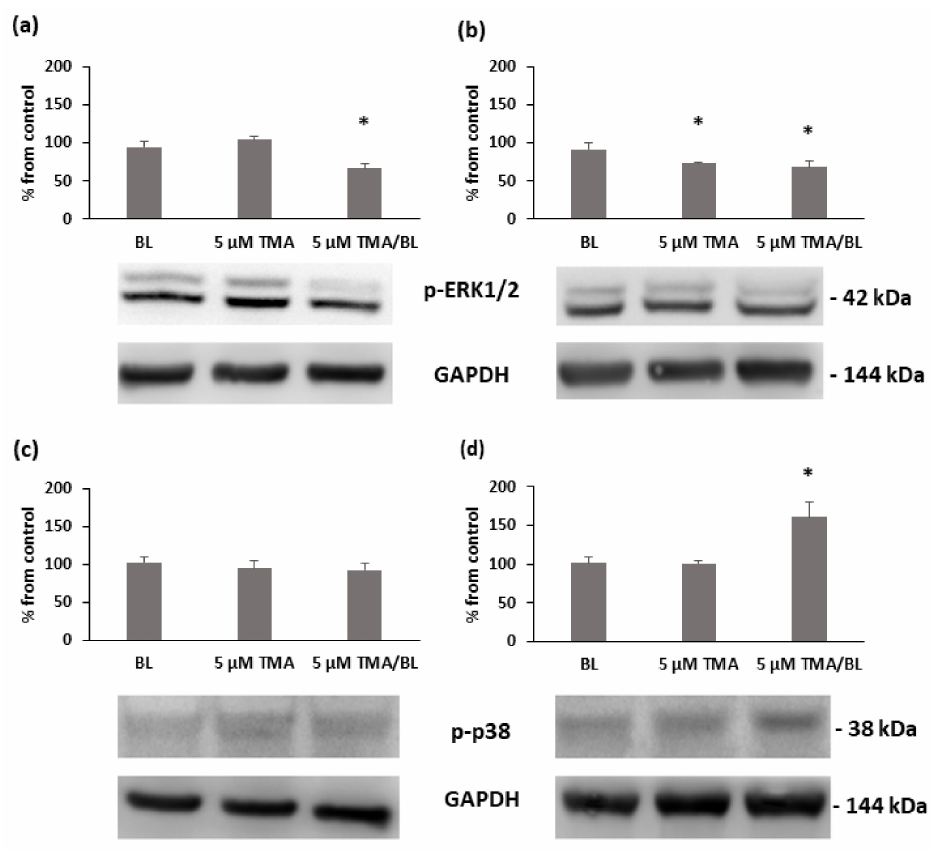
Figure 8. Expression of the phosphorylated forms of ERK 1/2 ( a , b ) and p38 ( c , d ) at 24 ( a , c ) and 48 ( b , d ) h after the treatment with TMA/BL (2 J/cm 2 ). Quantification of the protein expression levels was performed by a densitometric analysis using ImageJ software, and the results are expressed as percentages of the control cultures * = p < 0.05 vs. the control cultures, Student’s t